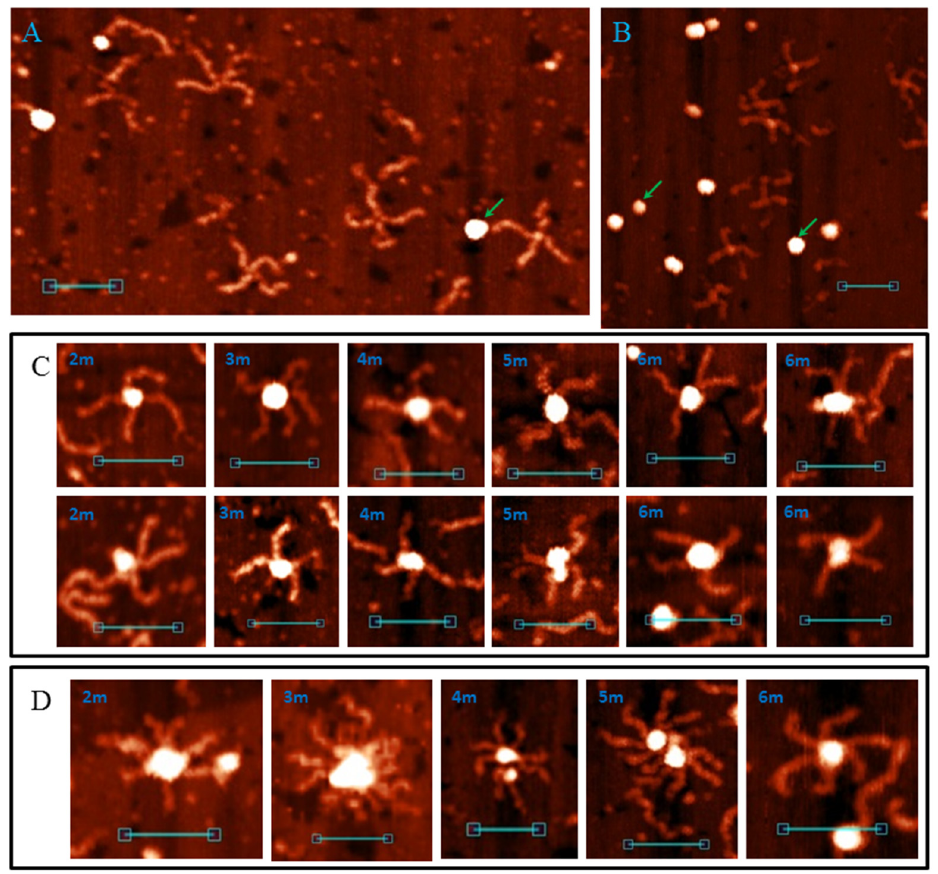
Figure 10. Interaction of the G4-specific antibody (1H6) with G4/IM-synaptic complexes and Holliday structure (HS). ( A ) AFM image of HS in extended conformation in the presence of 1H6 antibody; ( B ) AFM image of HS in a stacked form in the presence of 1H6 antibody; ( C ) Interaction of 1H6 antibody with cruciform G4/IM-synaptic complexes; ( D ) Interaction of 1H6 antibody with higher order synaptic complexes. Antibody molecules are marked with arrows.